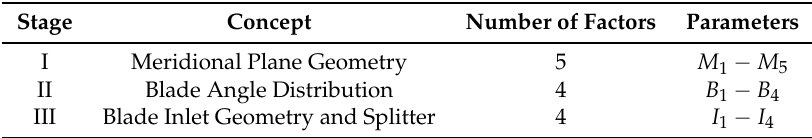
Table 1. Stages I to III for recognizing the effective parameters.